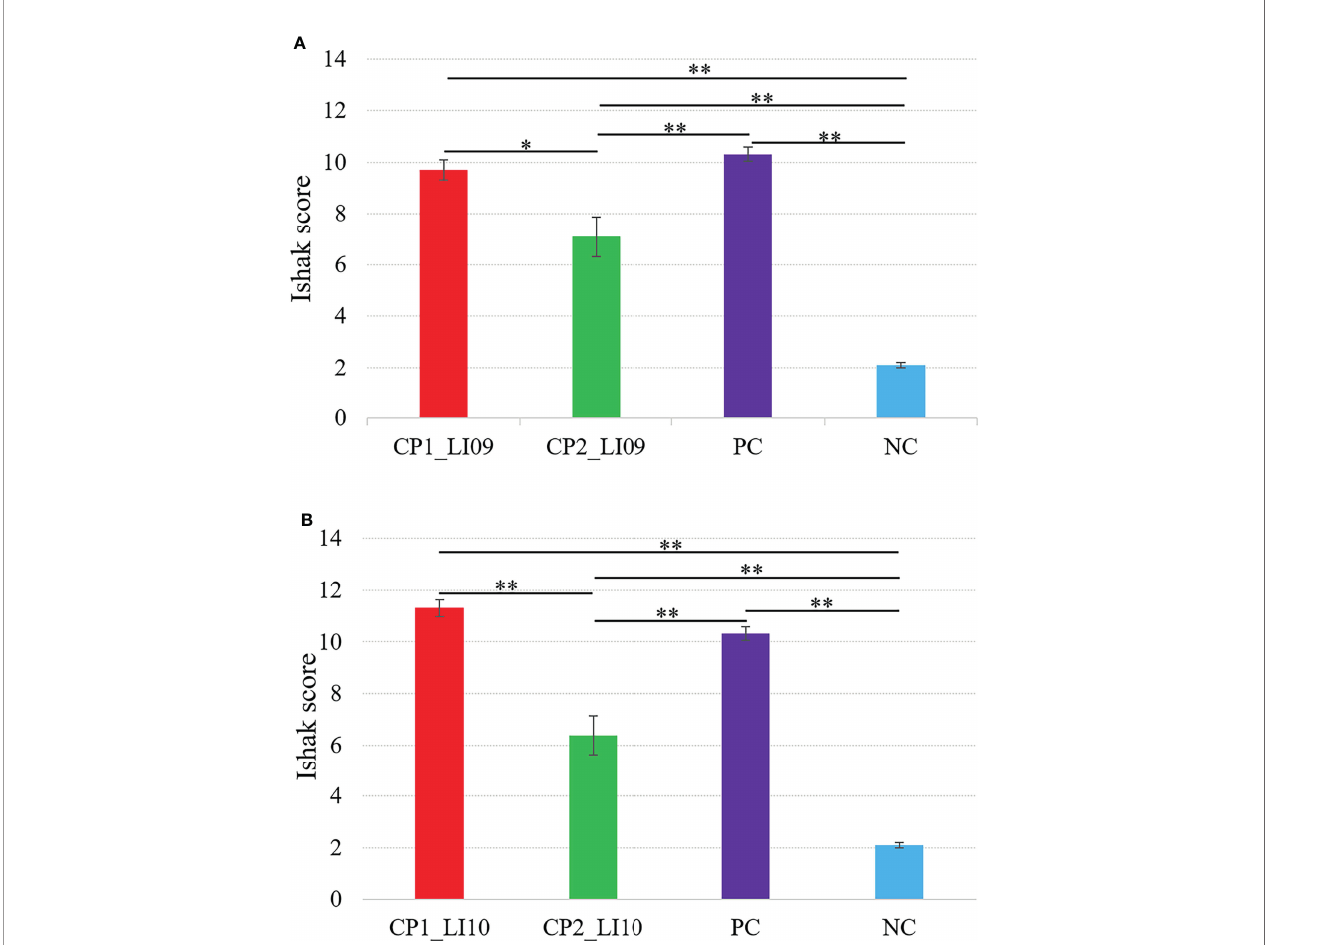
FIGURE 4 | Comparisons of Ishak scores in the (A) LI09 cohorts with different cytokine pro fi les (i.e., CP1_LI09 and CP2_LI09 cohorts) and control cohorts and (B) LI10 cohorts with different cytokine pro fi les (i.e., CP1_LI10 and CP2_LI10 cohorts) and control cohorts. PC represents positive control; NC represents negative control. * represented 0.01 < P < 0.05; ** represented P <